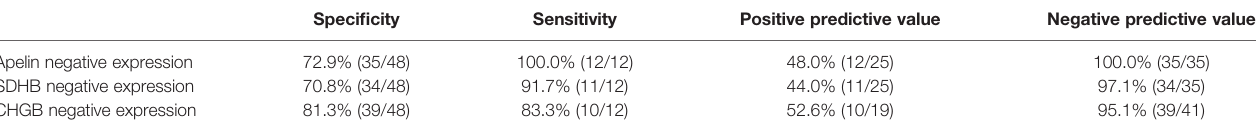
TABLE 3 | Speci fi city, sensitivity, positive and negative predictive value of apelin, SDHB and CHGB in differentiating metastatic from non-metastatic pheochromocytoma and